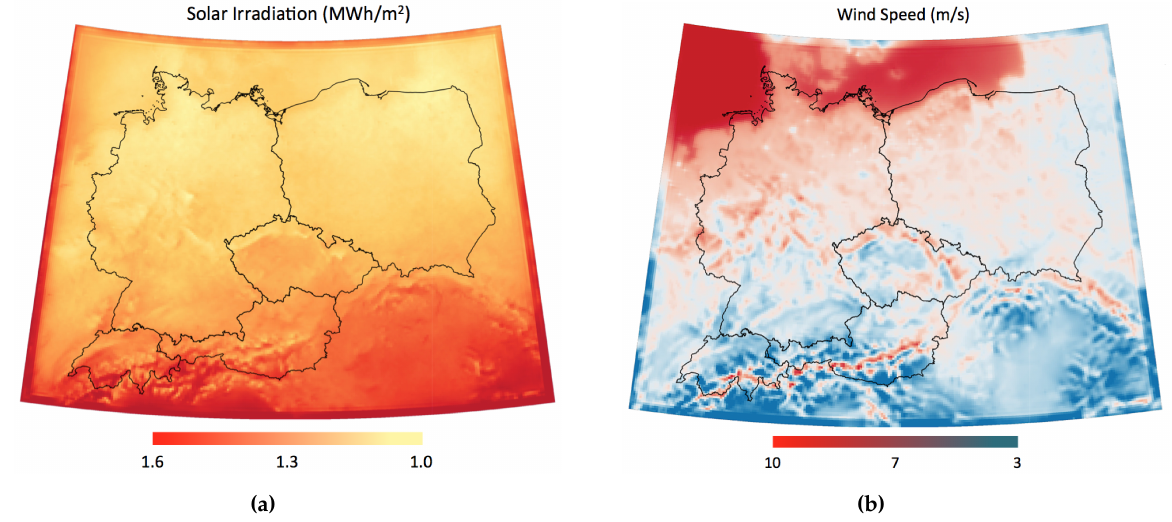
Figure 2. Simulated annual average solar and wind resources for Central Europe (Germany, Austria, Switzerland, Poland, the Czech Republic) in 2013. ( a ) Solar irradiation (ground level); ( b ) Wind speed (100m above ground